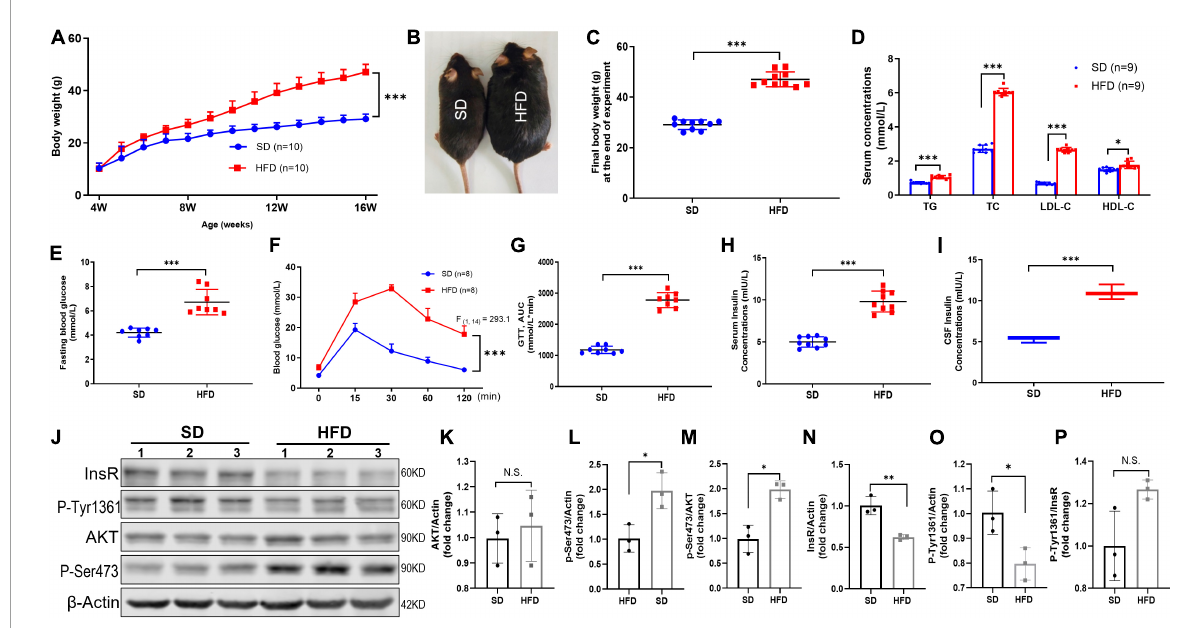
FIGURE1 HFD led to increased body weight, disorder of systemic glucose/lipid metabolism, hyperinsulinemia, and brain IR in mice. (A) Body weight changed of mice fed with SD and HFD. n = 9 per group. (B) Representative photographs of the SD and HFD feeding mice at the end of experiment. (C) The final body weight at the end of experiment in SD and HFD feeding mice. (D) The circulating lipids levels in the SD and HFD groups. n = 9 per group. (E) The fasting blood glucose average levels in the SD and HFD feeding mice. n = 8 per group. (F) Blood glucose concentration at different time points after glucose intraperitoneal injection in GTT. n = 8 per group. (G) AUC values of GTT were calculated and compared between SD and HFD group mice. n = 8 per group. (H) Serum insulin concentrations in SD and HFD group. n = 9 per group. (I) CSF insulin concentrations in SD and HFD group. n = 9 per group. (J) Representative blot images of Western blot for total AKT, p-AKT (Ser473), InsR, and p-InsR (Tyr1361) in mice whole brains, β -Actin served as an equal loading control. (K–P) The corresponding densitometry of total AKT (K)